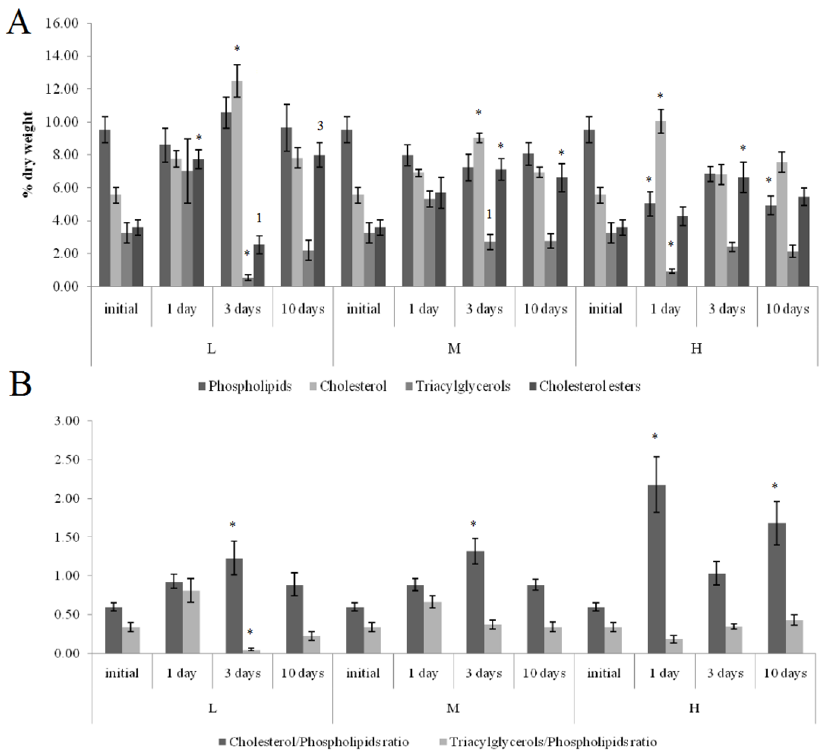
Figure 3. Lipid classes levels ( A ) and ratios ( B ) in the gills of horse mussels under low (L), medium (M), and high (H) crude oil concentrations. Values are means ± standard error ( N = 5). * significant results in comparison with initial level; 1, 3—significant results in comparison with the first and third days of exposure. Differences were estimated by the nonparametric Kruskal–Wallis test, p < 0.05 .